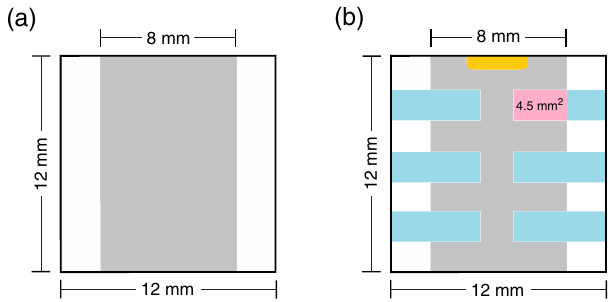
FIG. 15. Schematic top views of (a) the bare glass/ITO substrate and (b) finished devices thereon. In panel (a), the 12 × 12 mm 2 glass substrate is partially covered by an 8 × 12 mm 2 ITO stripe (grey). The thickness of the ITO layer varies from 150 to 250 nm depending on batches of manufacture. The total thickness of the substrate is about 1 mm; in panel (b), six top electrodes (sky blue) are deposited via thermal evaporation under high vacuum ( ≤ 10 − 6 mbar) through a shadow mask, thereby forming six induvial devices (pink). The overlap between the top contact and ITO stripe defines the effective geometric area for each single device ( ∼ 4 . 5 mm 2 ). Electrical connection to the bottom ITO electrode is established by applying conductive silver paste (orange) at either edge of the ITO stripe after physically removing the local active layer. Such a configuration allows for characterization of six devices on one substrate and hence comparison of their